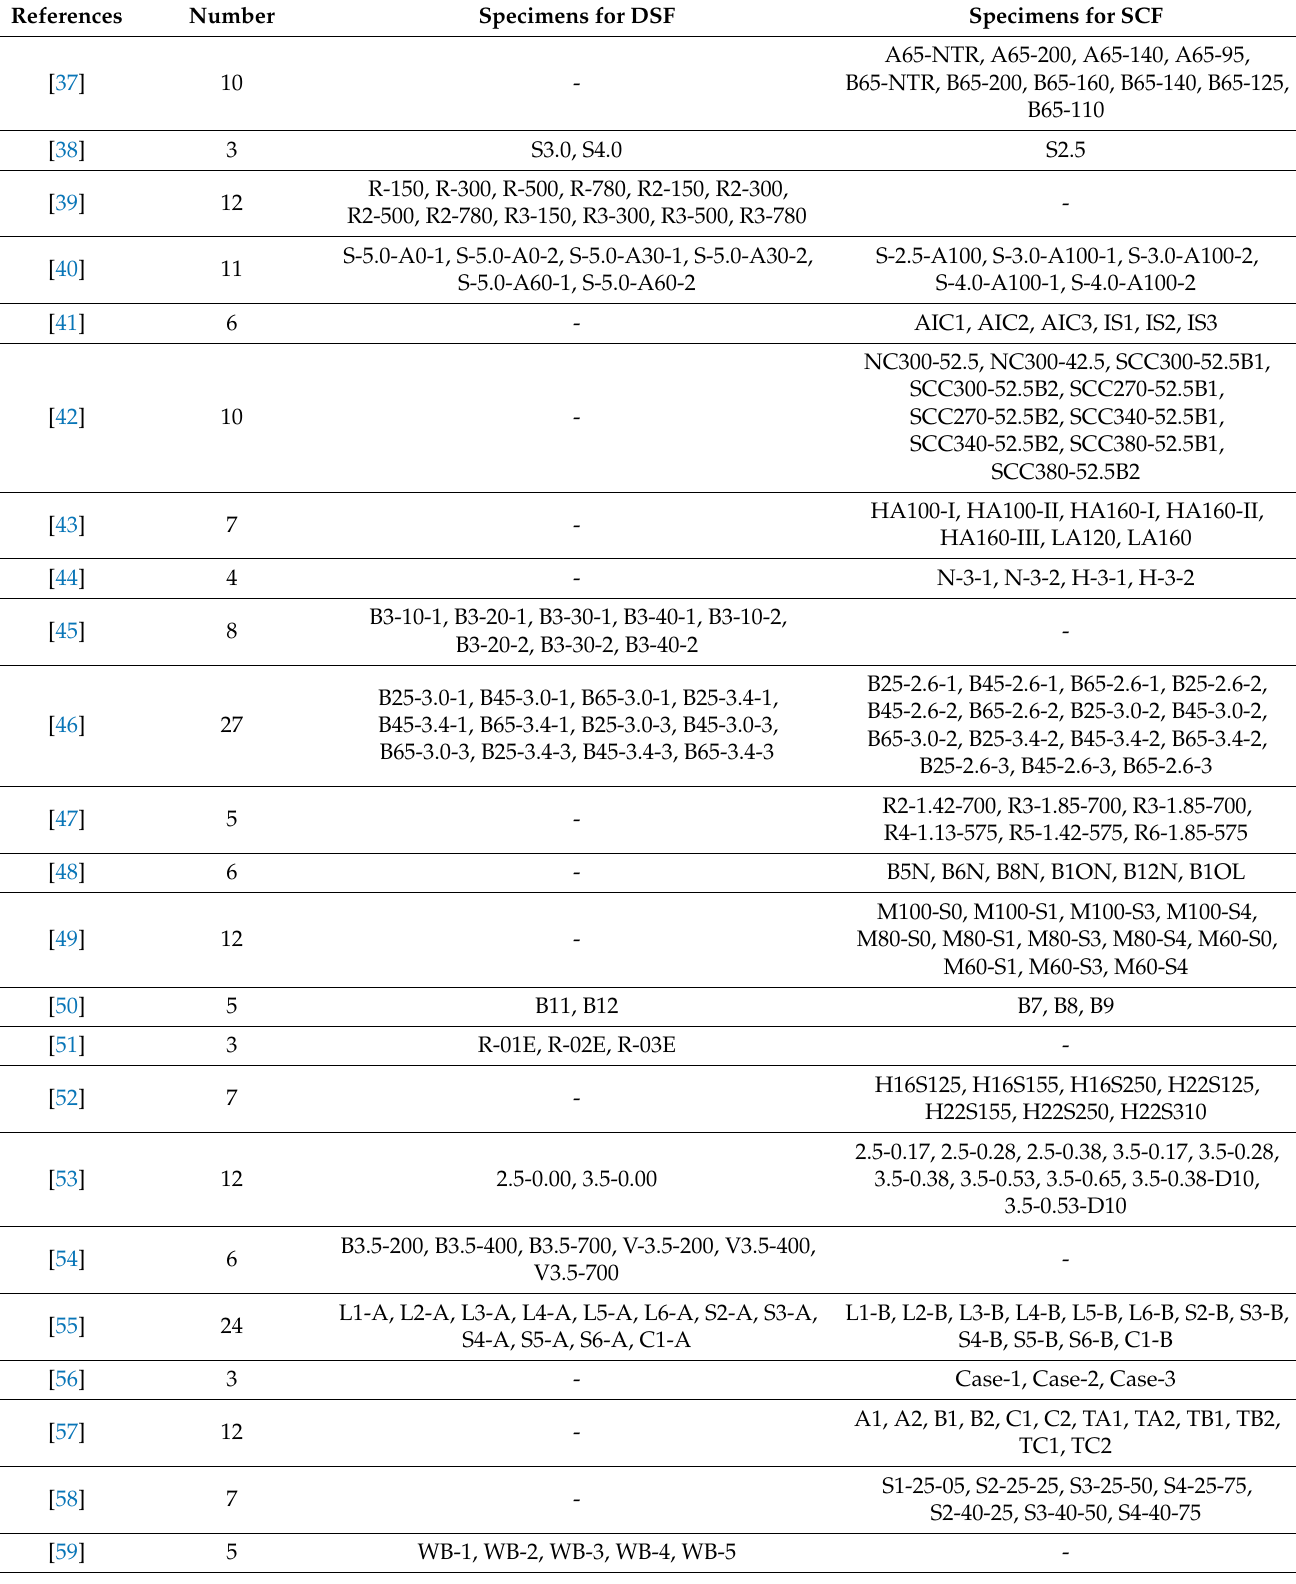
Table A1. Experimental dataset of RC